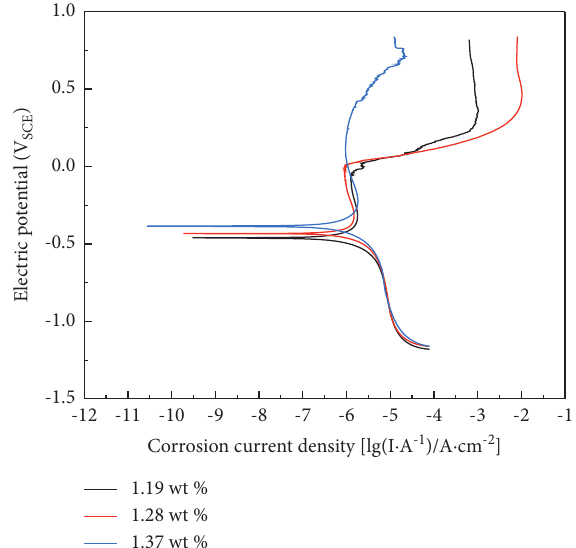
Figure 5: Corrosion depth of the HNNS samples after their immersion in a 6% FeCl and (c) 1.37 wt.% N.